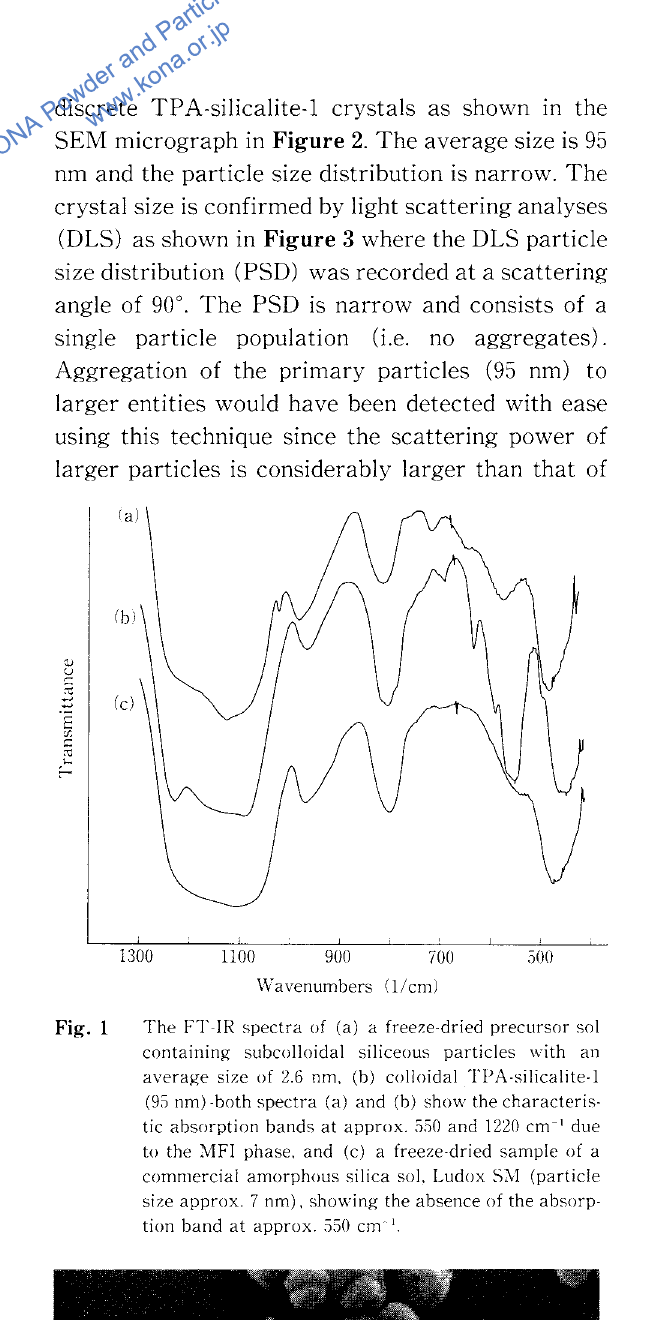
The crystal size distribution of a colloidal dispersion of TPA-silicalite-1 measured using dynamic light scatter- ing.